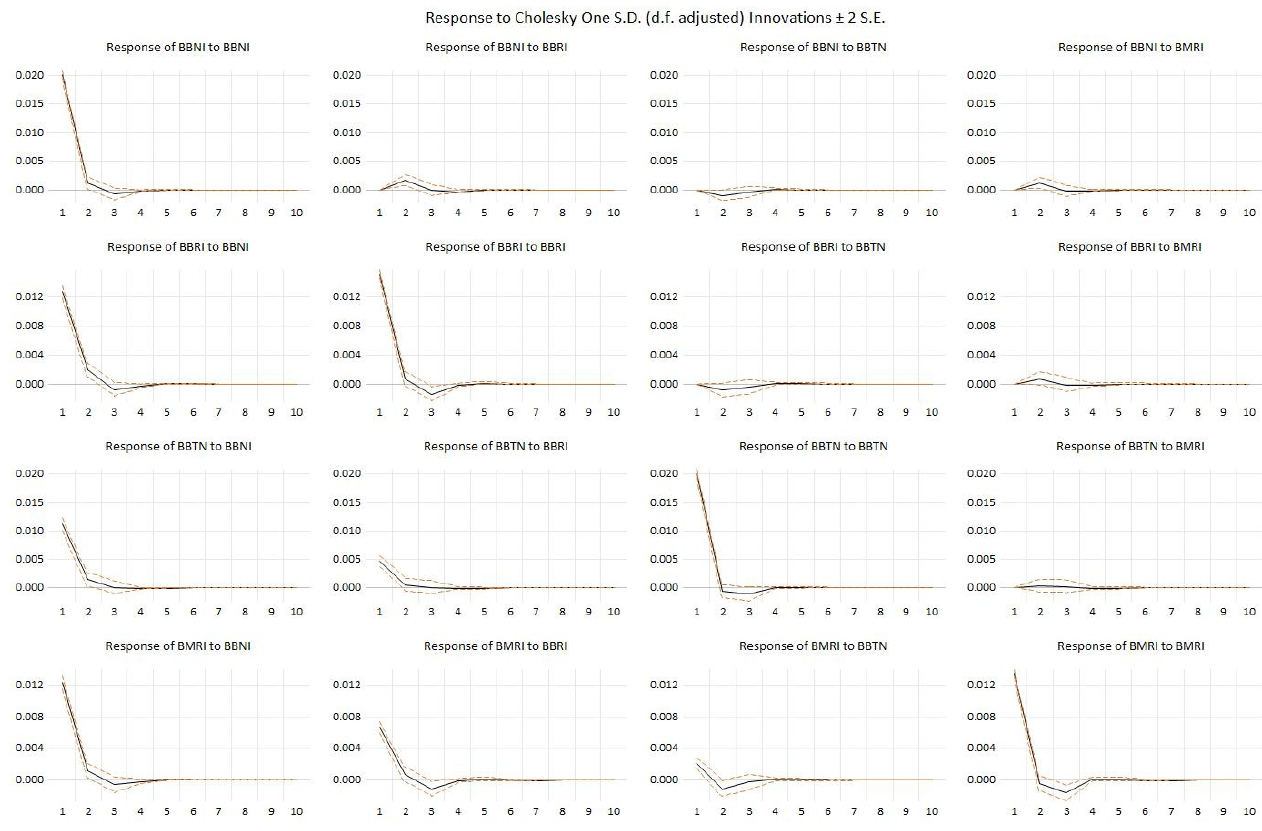
Figure 3. Multiple graphs for IRFs.